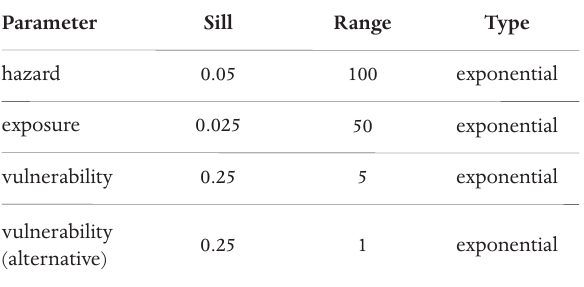
Table 3. Autocorrelation parameters for the stochastic generation of the test distributions.